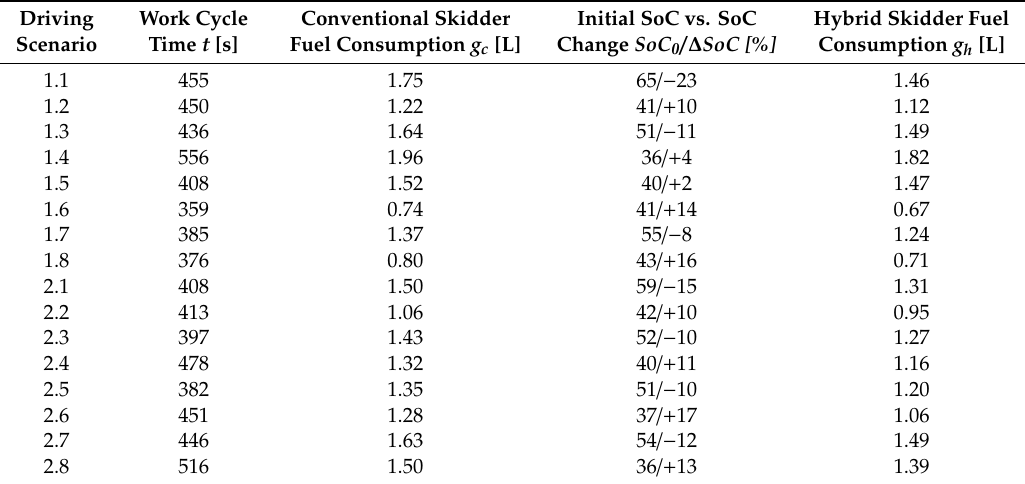
Table 8. Overview of driving scenarios for the skidder’s work day.